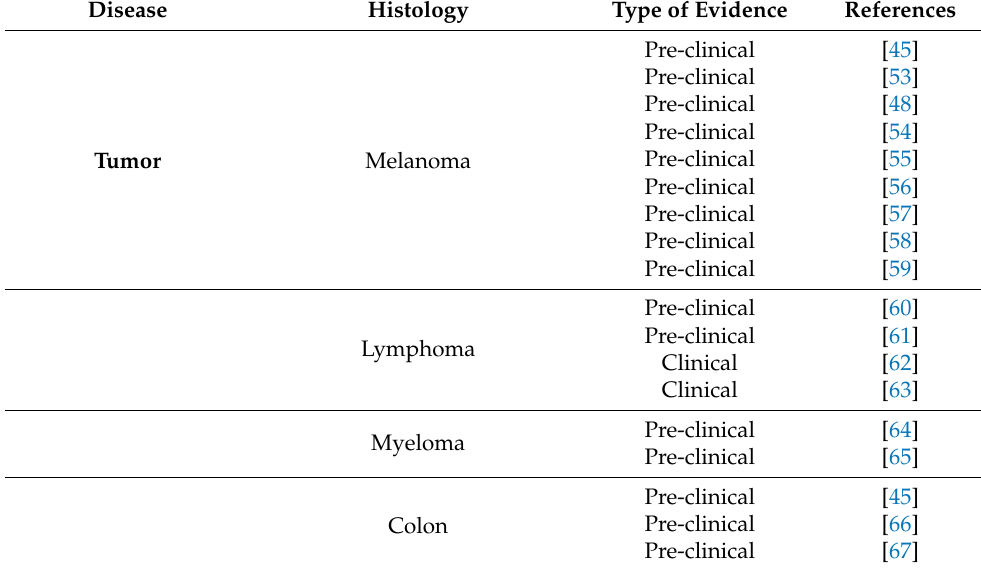
Table 1. pH and diseases. Direct and indirect evidence that microenvironmental acidity is involved in human